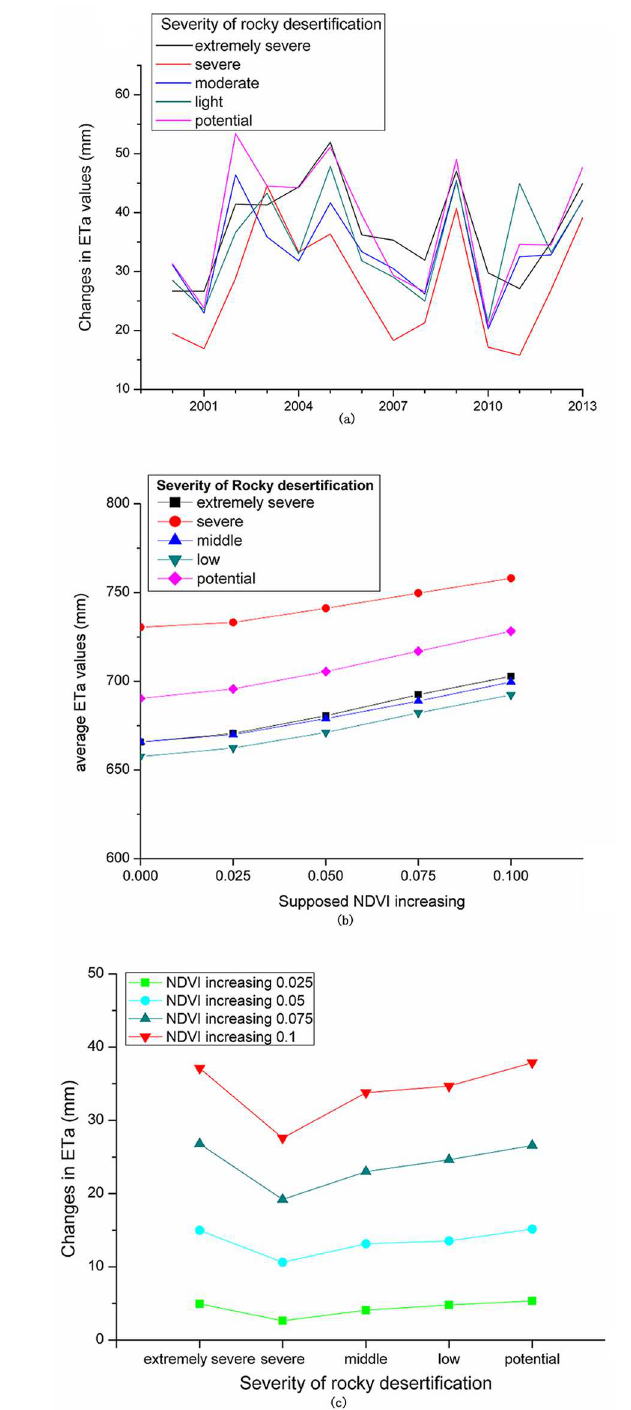
Fig 7. ETa values responses to increasing NDVI for different severity categories of rocky desertification. ( a ) changes in ETa values with NDVI increasing of 0.1 from 2000–2013; ( b ) average annual ETa values with NDVI increasingof 0.025, 0.05, 0.075, and 0.1; and ( c ) changes in averageannualETa values with NDVI increasingof 0.025, 0.05, 0.075, and 0.1.